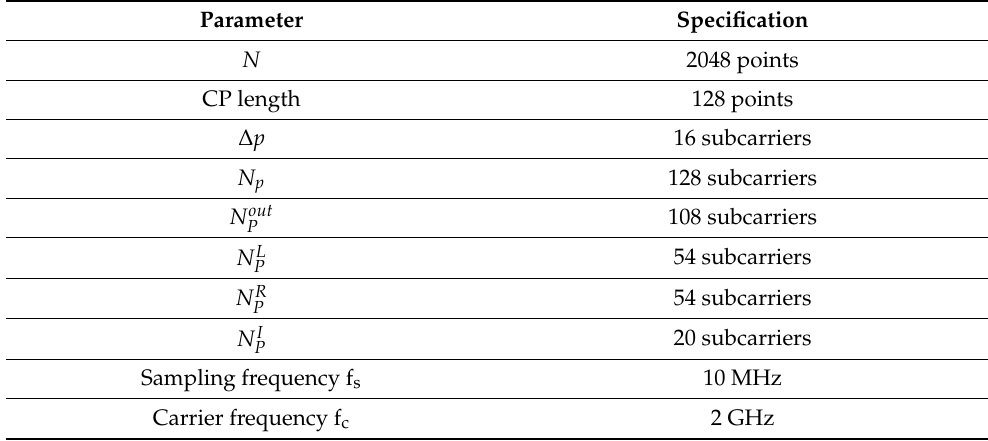
Table 3. Simulation parameters.